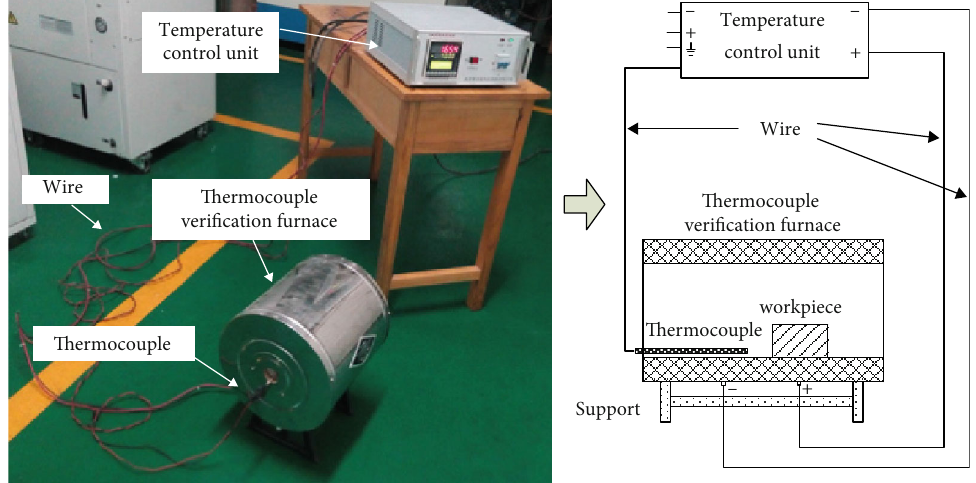
Figure 6: Heating furnace and temperature control